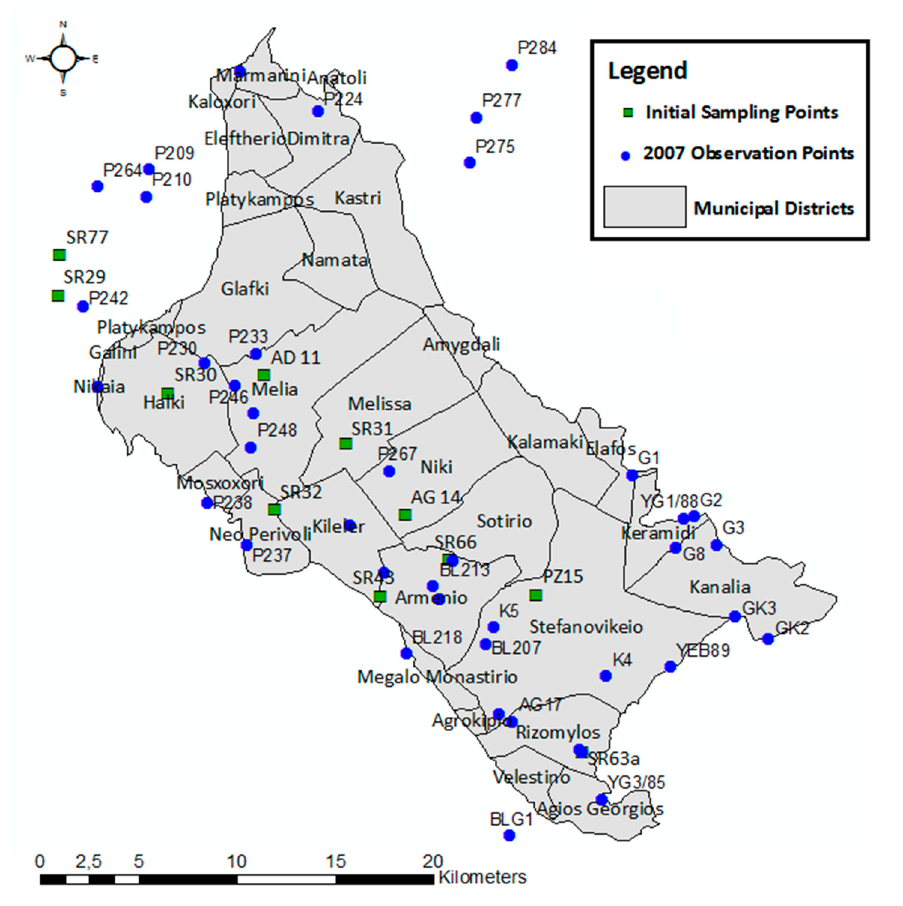
Figure 3. Location of wells and Municipal